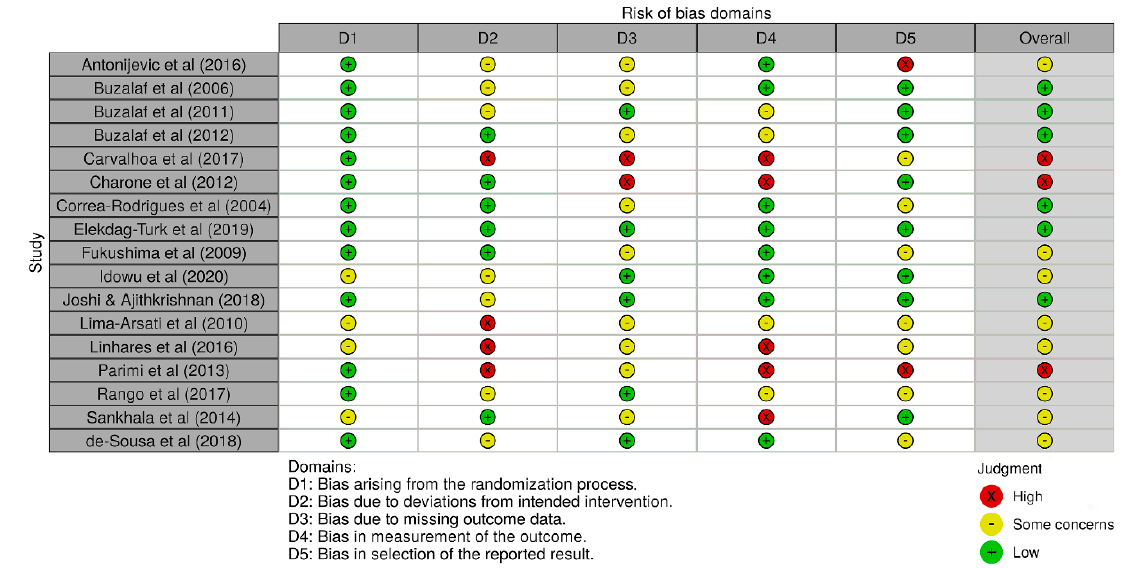
Figure 2. Risk of bias in individual studies. Some concerns of bias predominated in most of the assessed studies, followed by low risk of bias, and finally, high risk of bias.